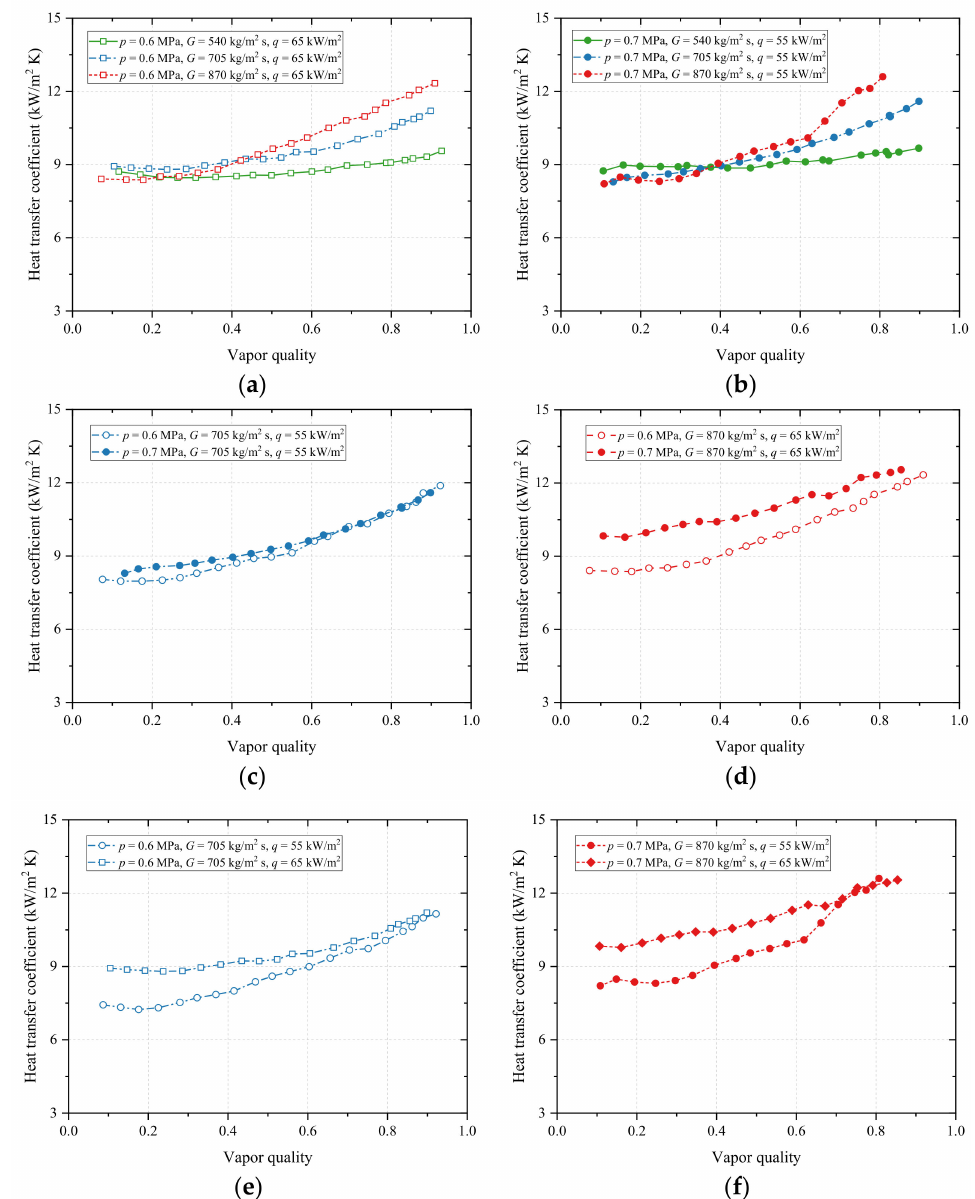
Figure 5. Flow boiling HTC of R1234ze(E) versus vapor quality: ( a ) effect of mass flux on HTC at p = 0.6 MPa and q = 65 kW/m 2 ; ( b ) effect of mass flux on HTC at p = 0.7 MPa and q = 55 kW/m 2 ; ( c ) effect of saturation pressure on HTC at G = 705 kg/m 2 s and q = 55 kW/m 2 ; ( d ) effect of saturation pressure on HTC at G = 870 kg/m 2 s and q = 65 kW/m 2 ; ( e ) effect of heat flux on HTC at p = 0.6 MPa and G = 705 kg/m 2 s; ( f ) effect of mass flux on HTC at p = 0.7 MPa and G = 870 kg/m 2